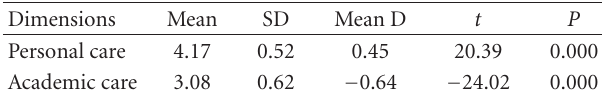
Table 5: Mean di ff erences between personal care and academic care with CTS ( n =